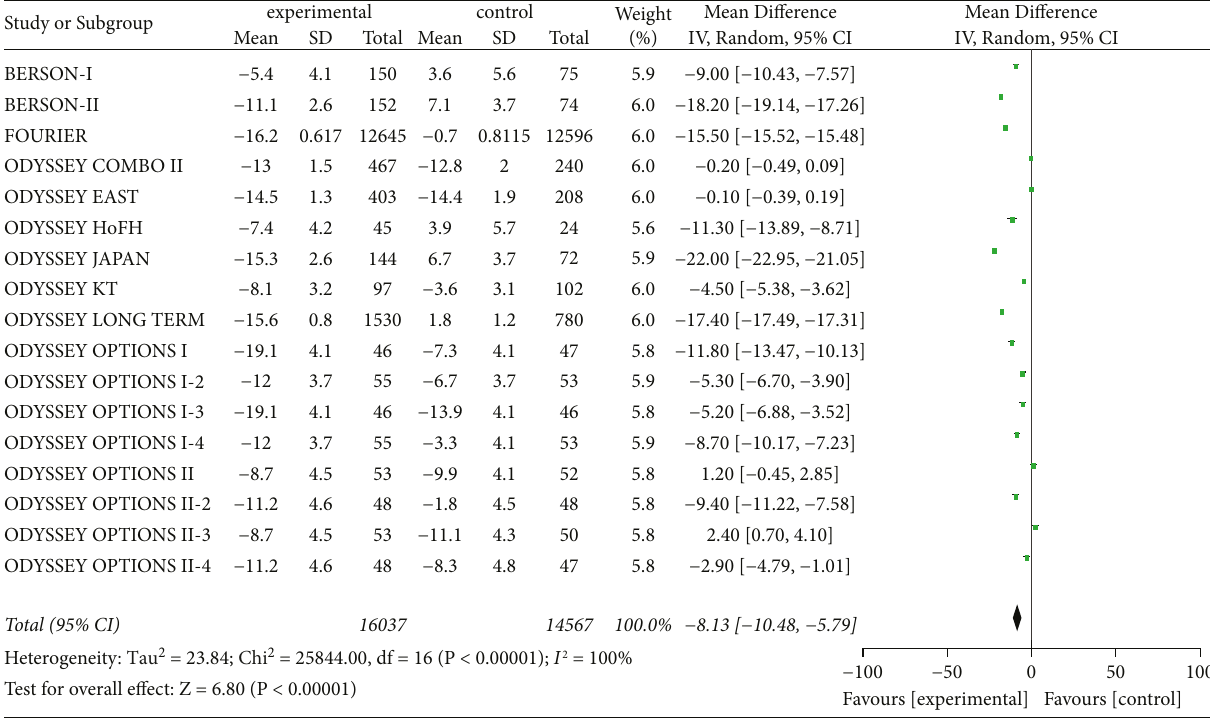
Figure 6: Comparison of the reduction of serum TG (%) from baseline between control group and experimental group.